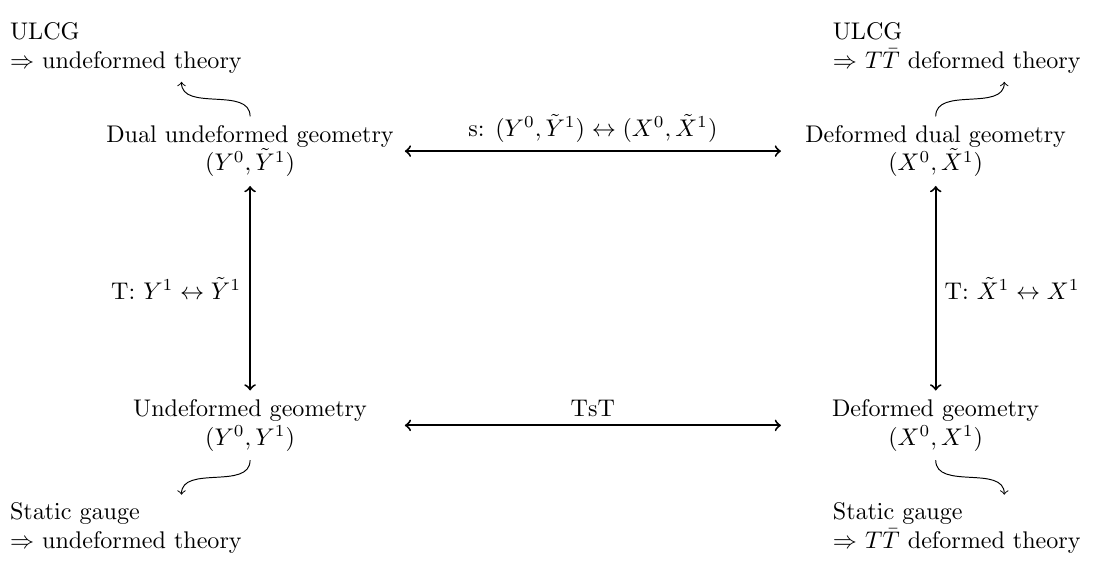
Figure 2 . A recipe for T (cid:22) T as TsT following [12,